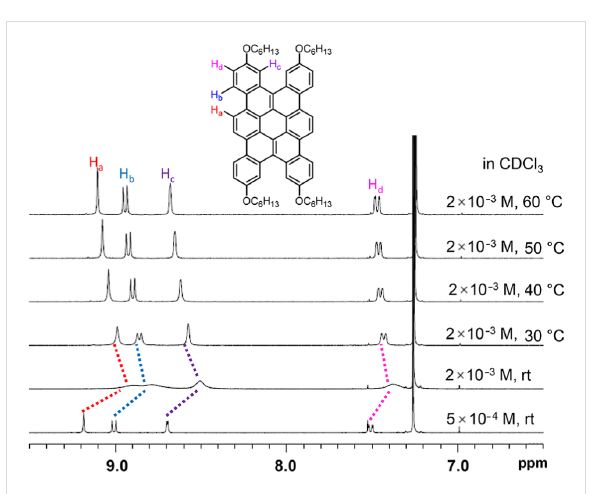
Figure 2: Effects of the concentration and the temperature on the 1 H NMR spectra of 7aa